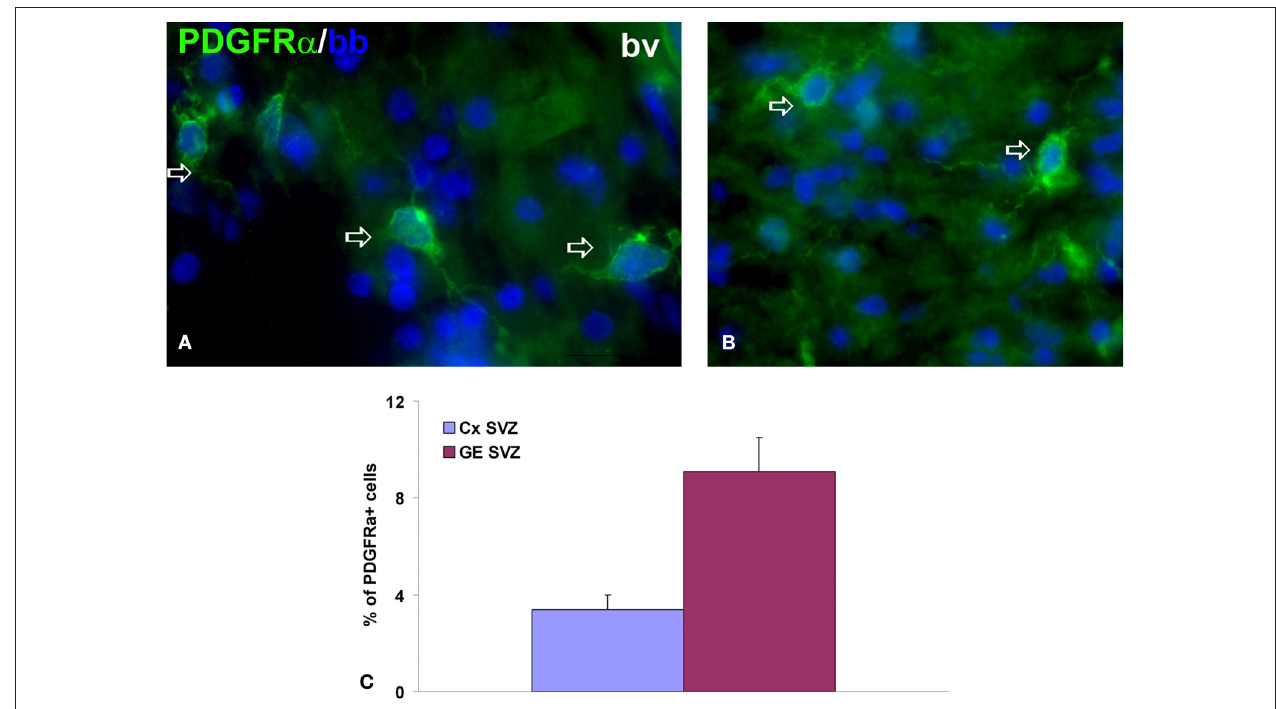
FIGURE 4 | Early oligodendrocyte progenitors in 15-week-old human forebrain. (A, B) Representative image of PDGFR α + early oligodendrocyte progenitors (green, arrows) in ganglionic eminence subventricular zone (GE SVZ,